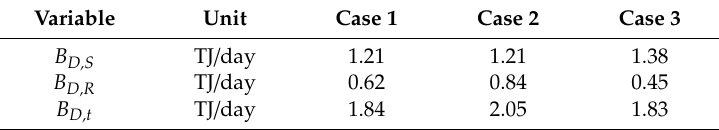
Table 3. APR1400 NHS&R System exergy destruction for analyzed cases.